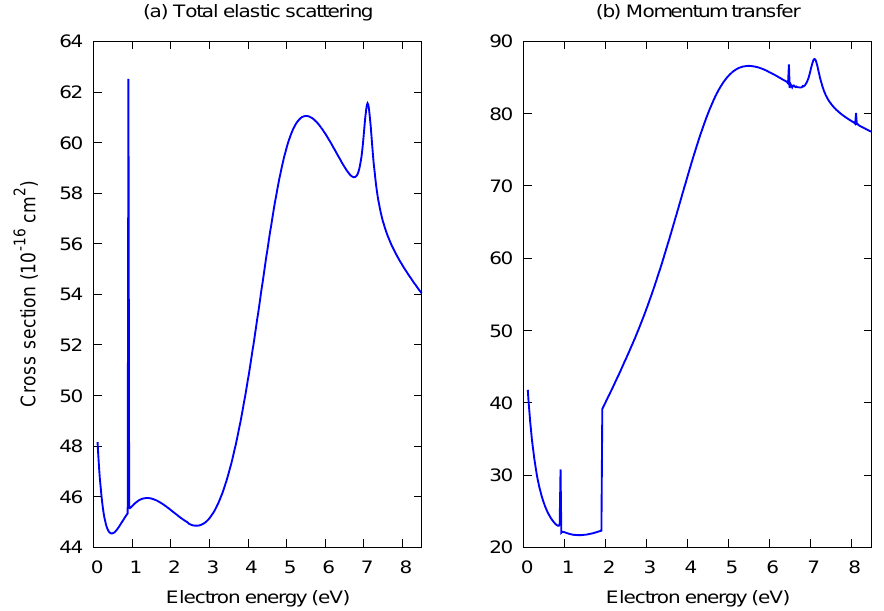
Figure 9. ( a ) Total elastic scattering and ( b ) momentum transfer cross